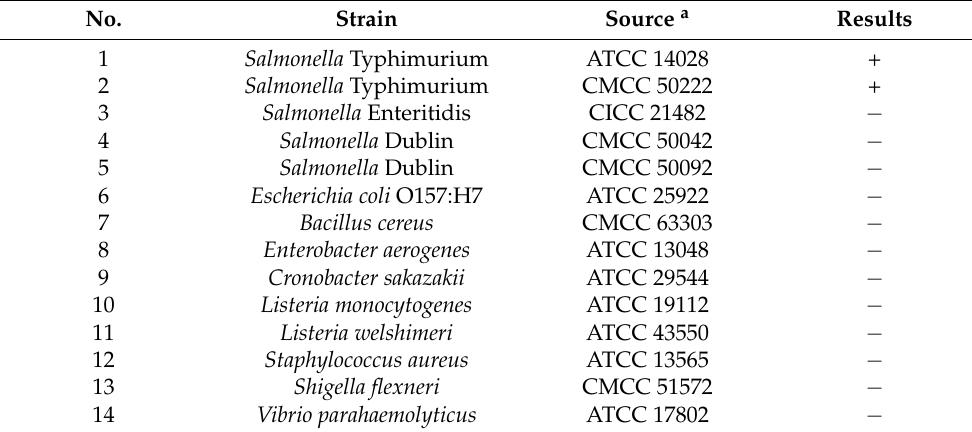
Table 2. Specificity analysis of enhanced LFA for Salmonella Typhimurium.